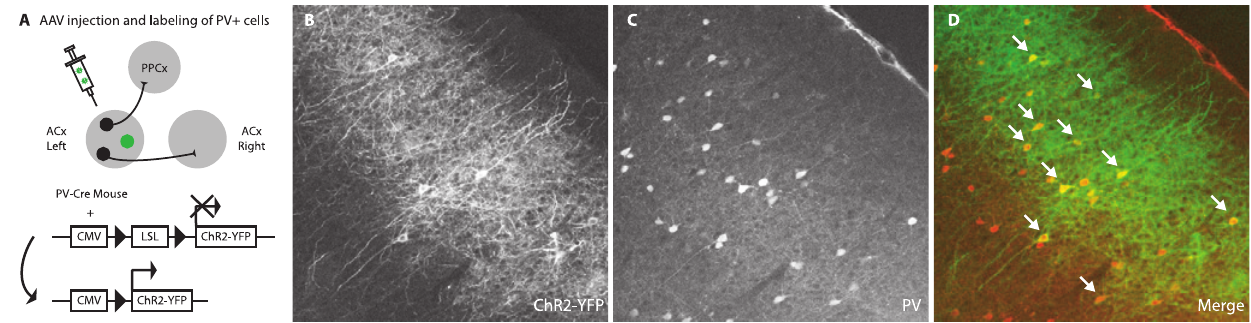
Figure 2. Viral-mediated expression of ChR2-YFP into a class of inhibitory interneurons in the mouse auditory cortex. (A) Neurons within the rodent auditory cortex can be excitatory or inhibitory. To express ChR2 in inhibitory parvalbumin expressing neurons of the mouse auditory cortex, we injected AAV carrying floxed ChR2-YFP in the left auditory cortex of PV-Cre mice, which express Cre recombinase only in fast- spiking interneurons. Although the virus can infect any cell, ChR2 is expressed only in PV-positive neurons. (B) Confocal micrograph of a section including the mouse primary auditory cortex shows fluorescence in cells expressing ChR2-YFP. (C) To test for PV specificity, the section was treated with an antibody against PV and counterstained with a red fluorescent dye. (D) Merging of the two channels shows that cells expressing YFP also counterstain for PV (merged cells show as yellow). Note that all ChR2 + (green) cells are also PV-positive (red) (i.e. there are only a few false positives), but that not all red PV-positive cells express